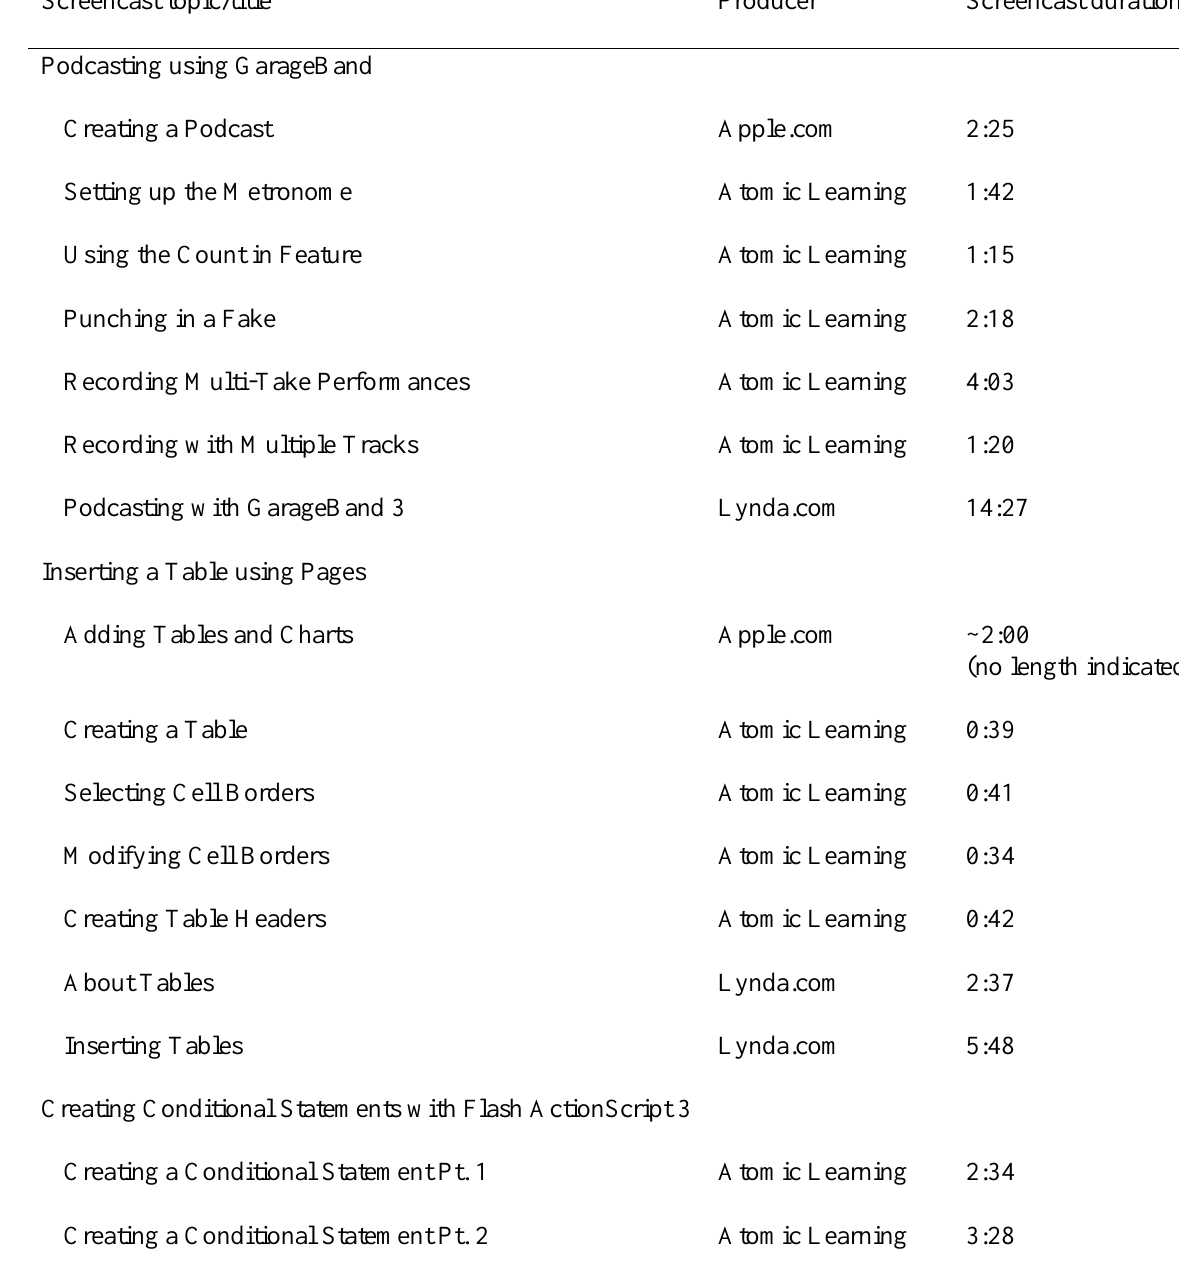
Creating Table Headers About Tables Inserting